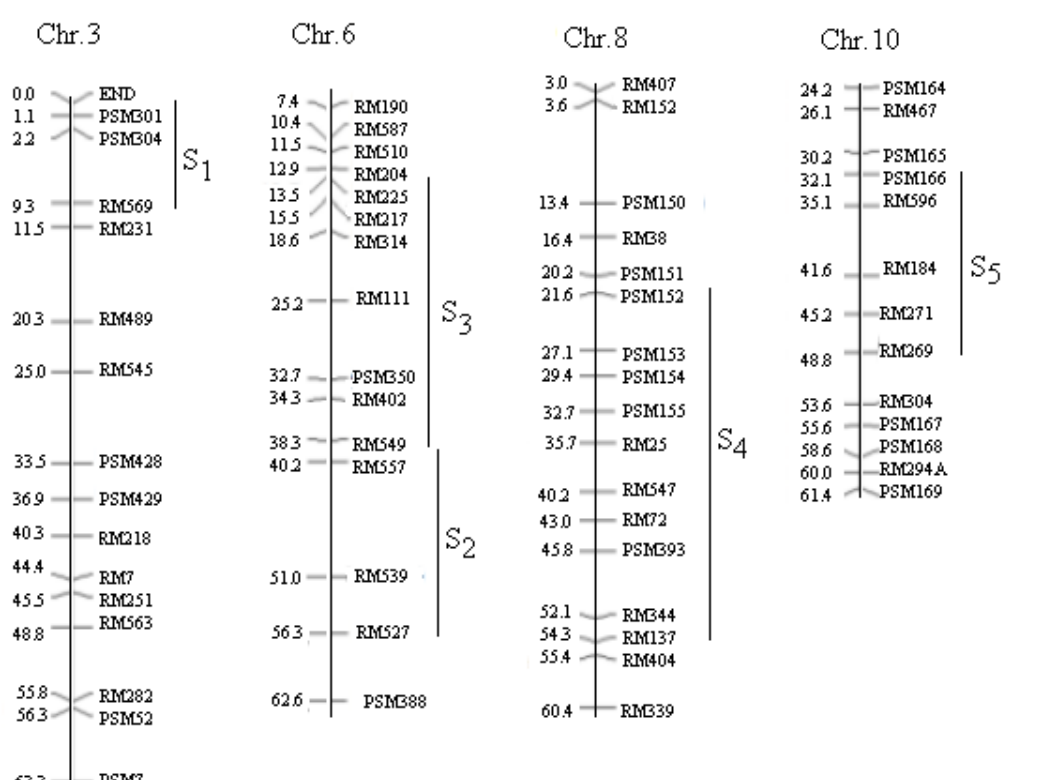
Figure 1. The approximate lengths and locations of the substitution segments on the chromosomes. Chr. is an abbreviation of chromosome, followed by the chromosomal number. Genetic distance (cM) and marker codes are listed on the left and right of Chr., respectively. The vertical lines on the right of Chr. represent substitution segments with serial numbers S i , which represent the i th SSSL.